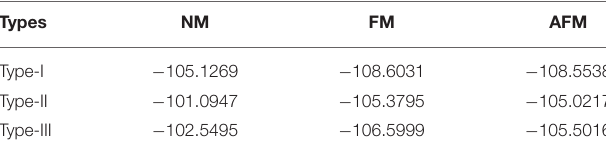
TABLE 2 | Total energies (eV) of CoCrScSn compound in NM, FM, and AFM